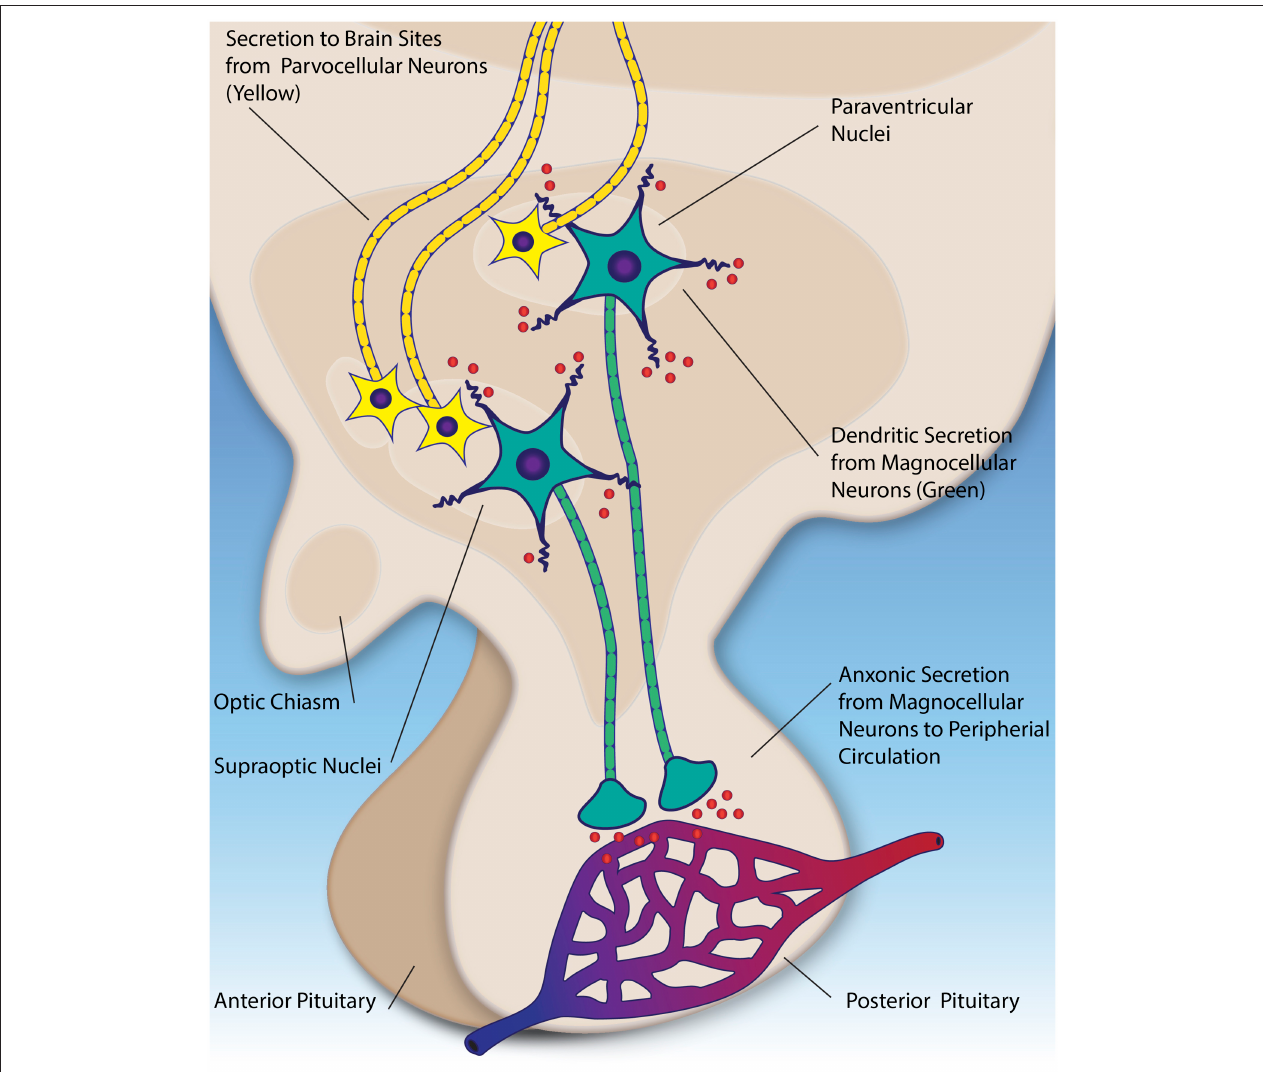
FIGURE 2 | Parvocellular neurons (yellow) secrete oxytocin and vasopressin (red) to numerous brain regions, including the amygdala, brainstem, and anterior pituitary. Magnocellular neurons (green) in the hypothalamic nuclei secrete oxytocin and vasopressin into the peripheral circulation via the posterior pituitary (axonic secretion). Additionally, they secrete these peptides into the extracellular fluid the hypothalamus (dendritic secretion).